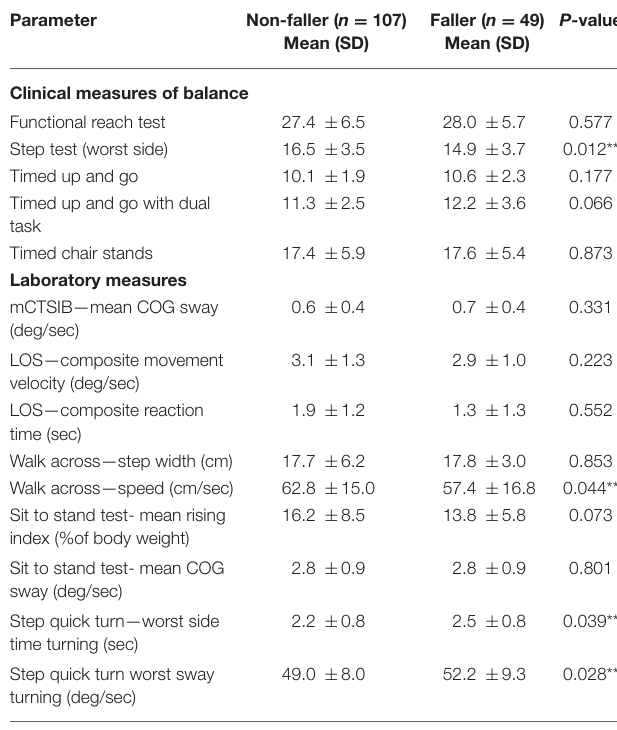
TABLE 5 | Univariate analysis of balance and mobility performance of participants by fall status. Parameter